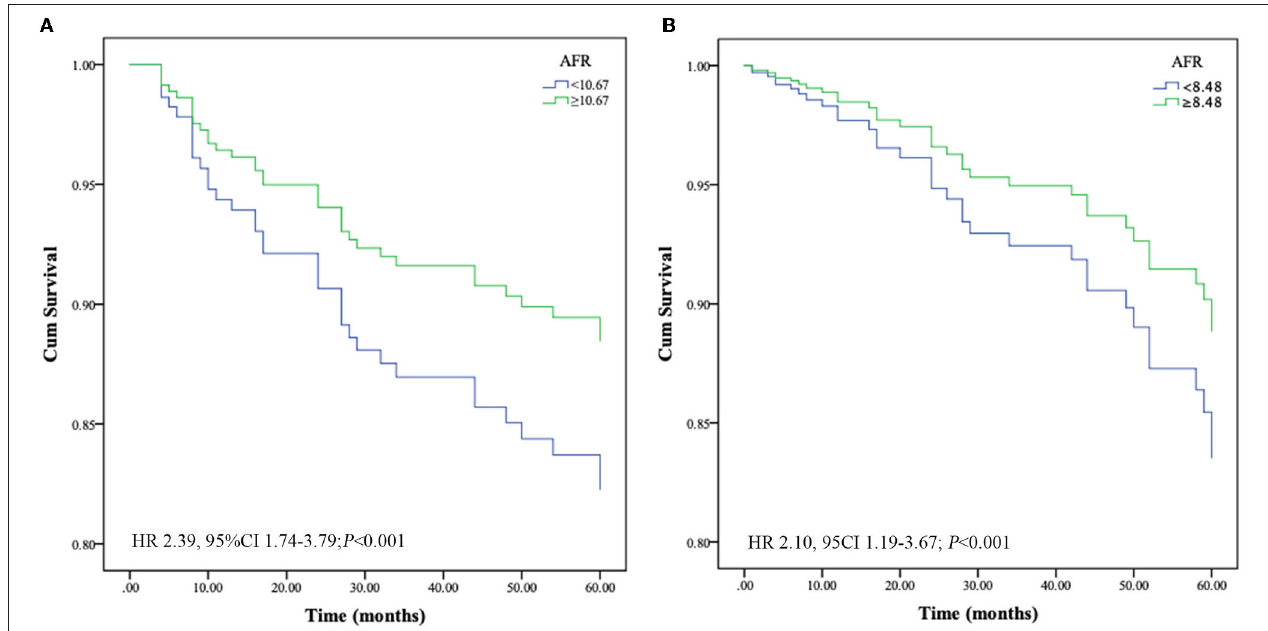
FIGURE 2 | Optimal thresholds for fibrinogen, albumin, AFR, and NLR were applied with ROC curves for (A) all-cause mortality and (B) cardiovascular mortality. NLR, neutrophil to lymphocyte ratio; AFR, albumin to fibrinogen ratio; AUC, area under curve; CI, confidence interval.